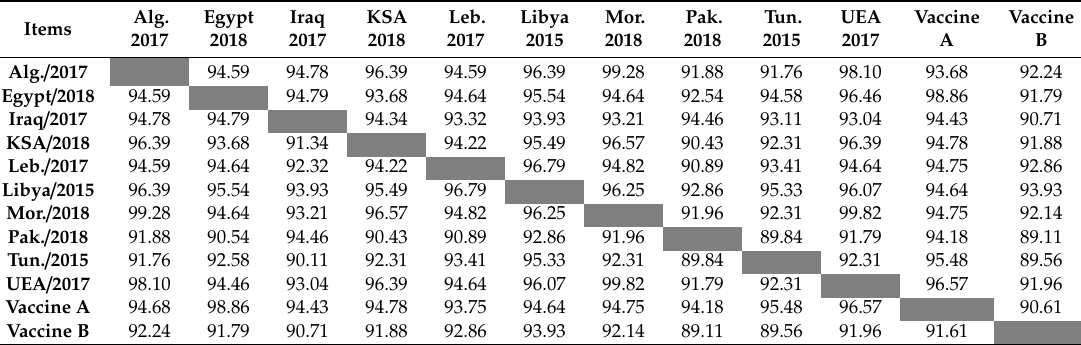
Table 2. Different avian influenza (AIV)-H9N2 virus hemagglutinin segment amino acid identity degrees. Alg. Items